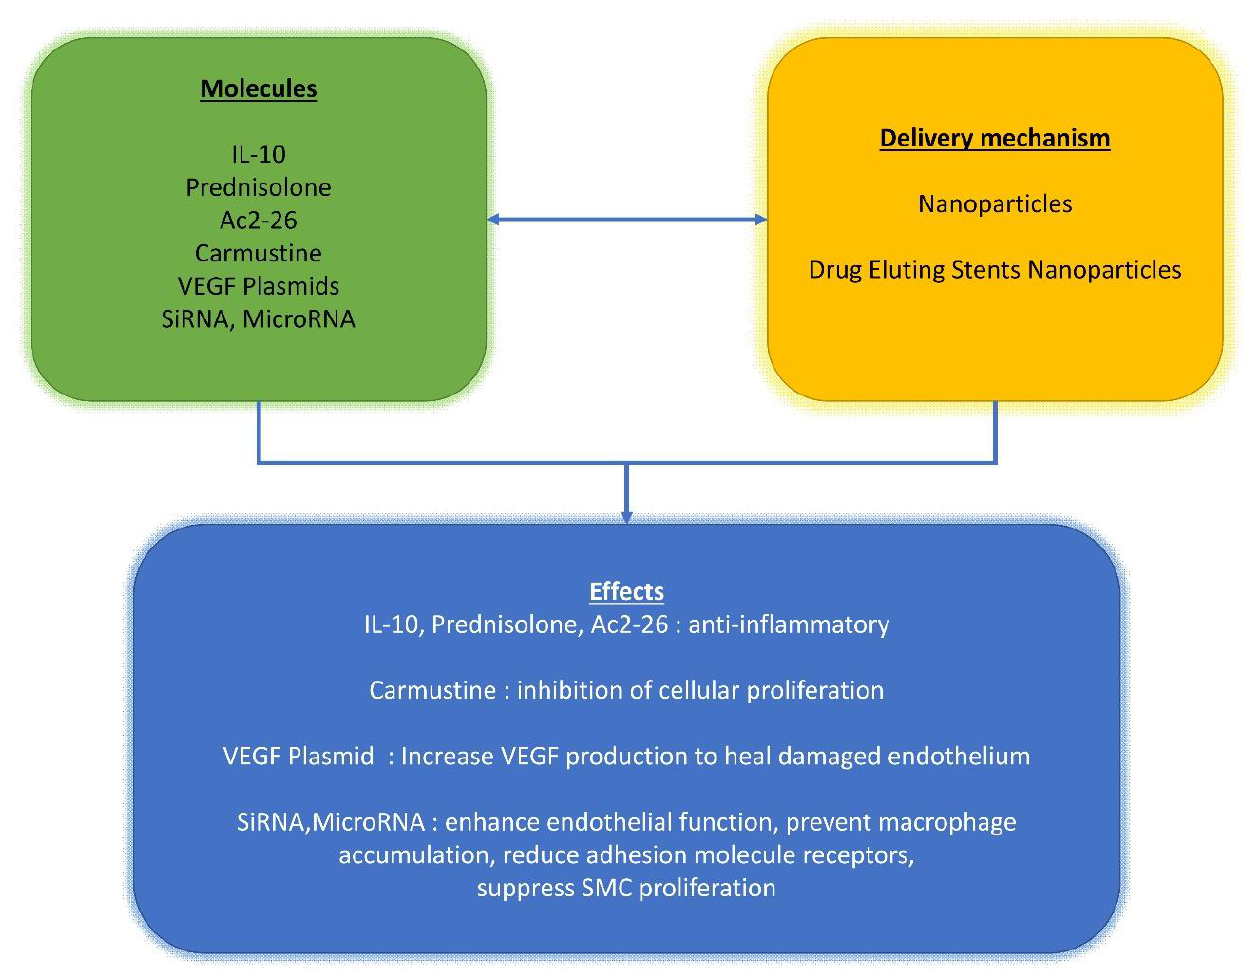
Figure 3. Schematic representation of different pathways described in the text. Effects of IL-10, Prednisolone, Ac2-26, carmustine, VEGF plasmids, siRNA, and microRNA (green box) and their delivery mechanisms (yellow box) and downstream effects (blue box).